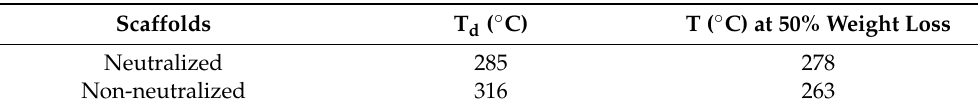
Table 2. Decomposition temperatures and weight loss of neutralized (N) and non-neutralized (NN) AH-crosslinked chitosan.